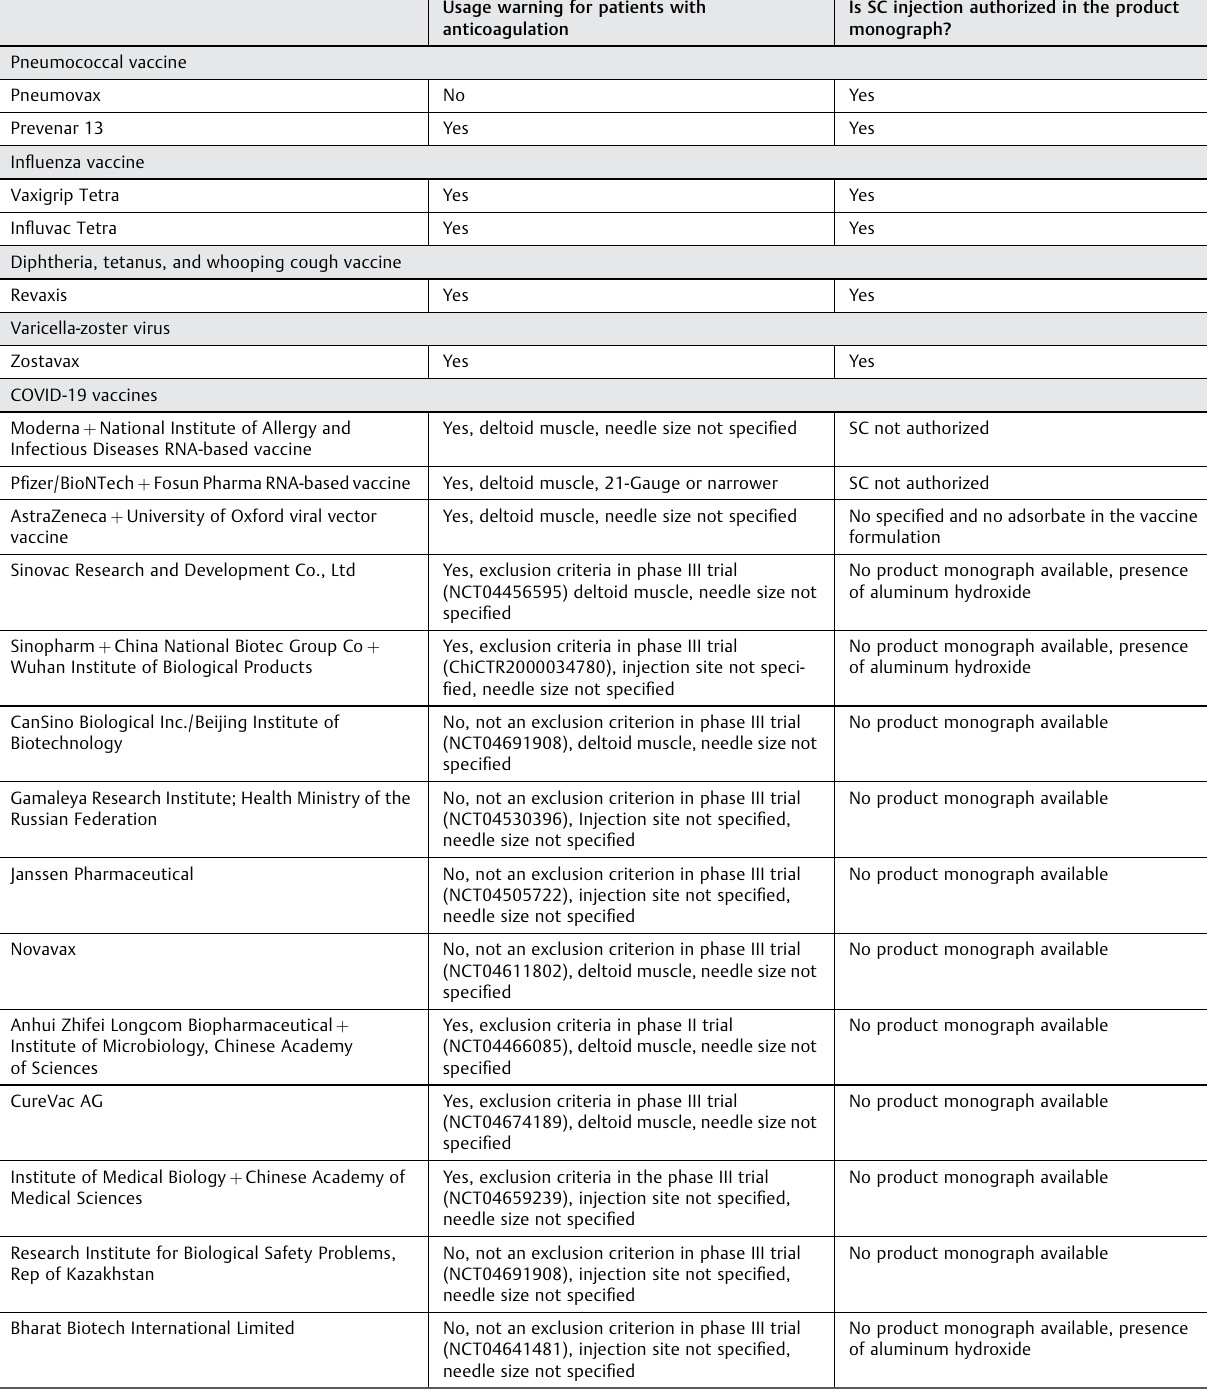
Table 1 Examples of information provided in the product monographs of vaccines Usage warning for patients with